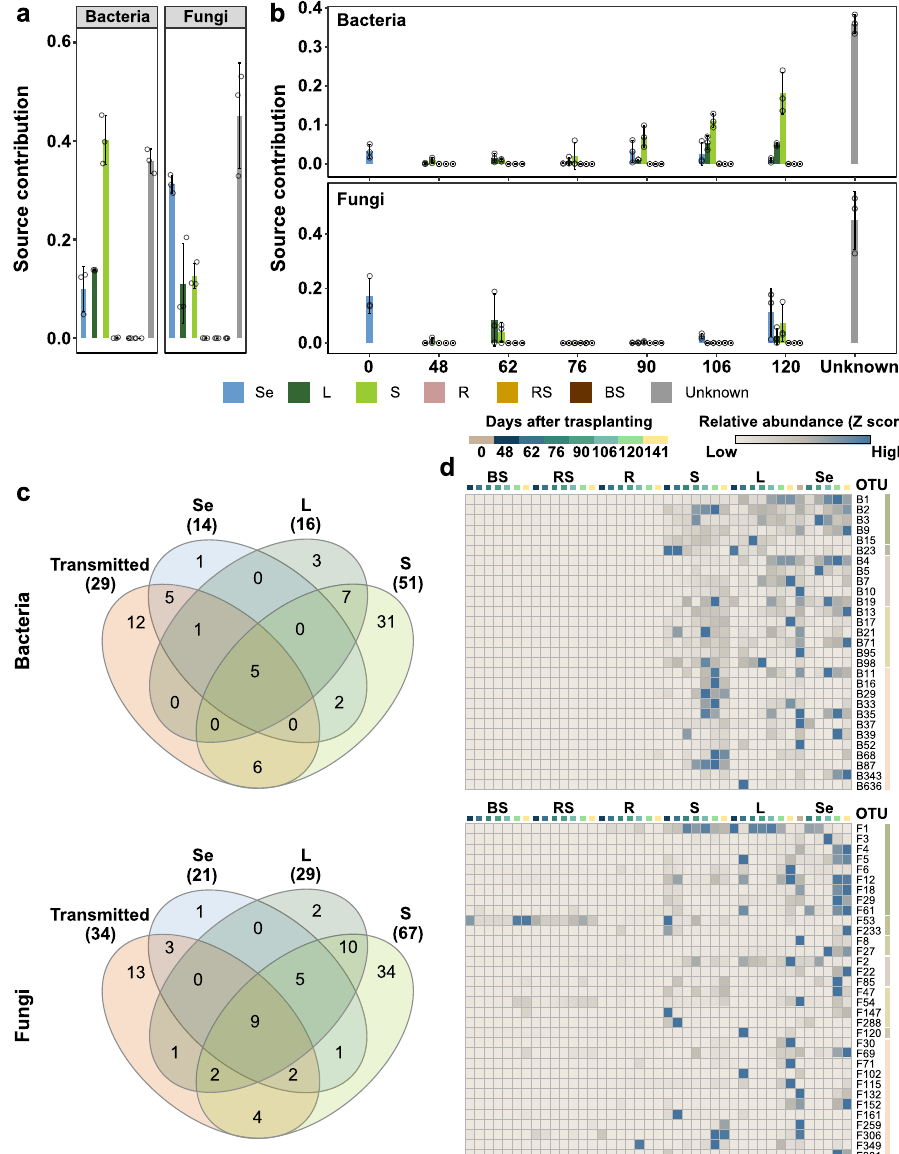
Fig. 4 Source and possible route for the transmission of seed microbial community. a Contribution of rice compartments to the formation of bacterial and fungal communities in progeny seeds at the harvest stage. b Contribution of rice compartments of each sampling time to the formation of bacterial and fungal communities in progeny seeds at the harvest stage. Error bars indicate the standard deviation of source contribution among plants. In a and b , dots indicate the estimated source contribution values in each repeat ( n = 3). Colors of bars correspond to each rice compartment (Se [seed], light blue; L [leaf], green; S [stem], light green; R [root], light red; RS [rhizosphere], dark yellow; BS [bulk soil], brown; Unknown [Unknown source], gray). c Venn diagrams on vertically transmitted bacterial and fungal OTUs and core OTUs of bacterial and fungal communities in the aboveground compartments (leaf, stem, and seed). Core OTUs were identi fi ed as OTUs detected at 80% of prevalence in each compartment. The list of core OTUs is available in Supplementary Data 5. d Heat maps on the distribution of vertically transmitted bacterial and fungal OTUs across rice compartments. Heat maps were constructed with Morpheus software (https://software.broadinstitute.org/morpheus/). Relative abundances of each OTUs were z score-transformed. The bluer the color of the box, the higher the relative abundance. Colors of the boxes below the initials of rice compartments indicate sampling points (day after transplanting to fi eld) when soil and plant compartment samples were collected. Colored bars next to the OTU labels correspond to the sections of the Venn diagrams in c . BS, bulk soil, RS, rhizosphere; R, root endosphere; S, stem endosphere; L, leaf endosphere; Se, seed; Transmitted, vertically transmitted